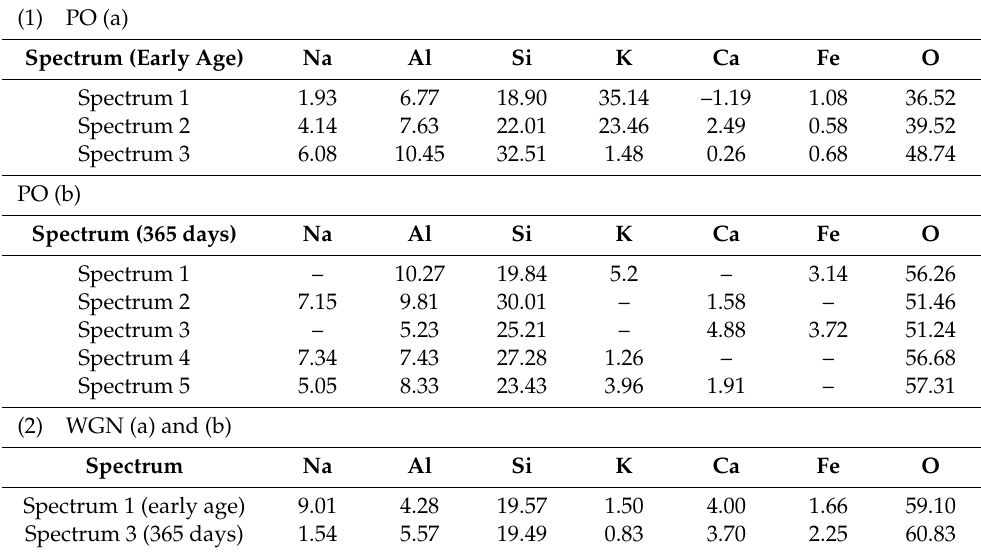
Figure 9. SEM images of the mortars ( a ) at an early age and ( b ) at 365 days (scale: 60 μ m for A, 60 and 30 μ m for PO, and 60 and 40 μ m for WGN mortars). Table 6. EDS spectrum analysis of ( 1 ) mortar PO and ( 2 ) mortar WGN (all results in atomic %).